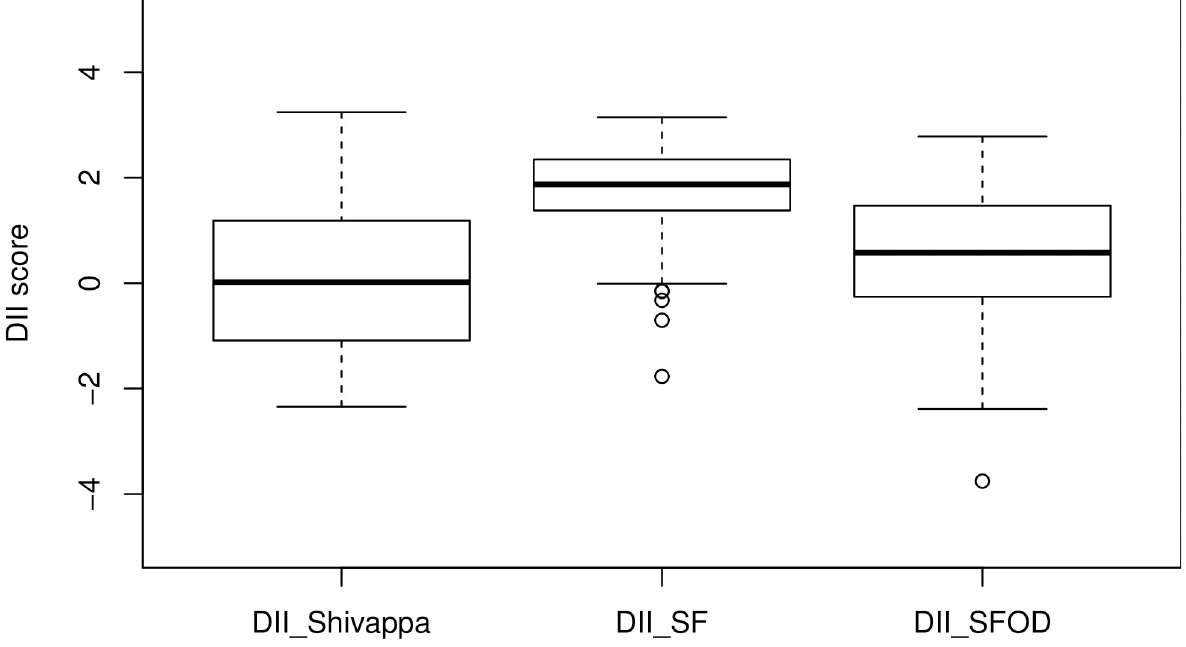
Fig 3. Boxplots of the dietary inflammatory index (DII) scores between the three different calculation methods. Nutritional data from n = 193 subjects participating in the TEENDIAB study were used to calculate the DIIs according to the original method from Shivappa et al. [17] or the revised methods scaling-formula (SF) and scaling-formula with outlier detection (SFOD), respectively.